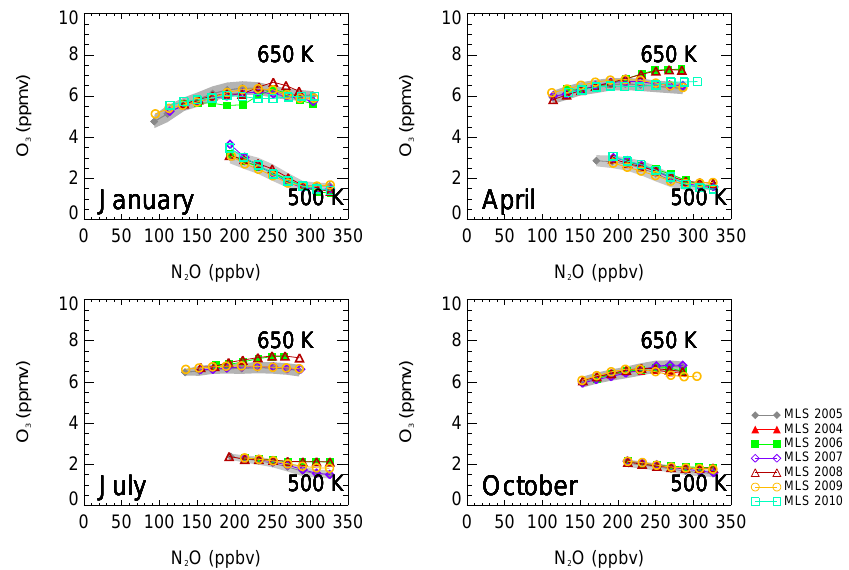
Fig. 4. Same as Fig. 3, but for MLS observations for the years 2004–2010: 2004 (red triangles), 2005 (grey diamonds) and 2006 (blue circles), 2007 (green squares), 2008 (violet diamonds), 2009 (dark red triangles), 2010 (gold circles). Note: 2005 is used here as reference since measurements of MLS started in mid-2004.